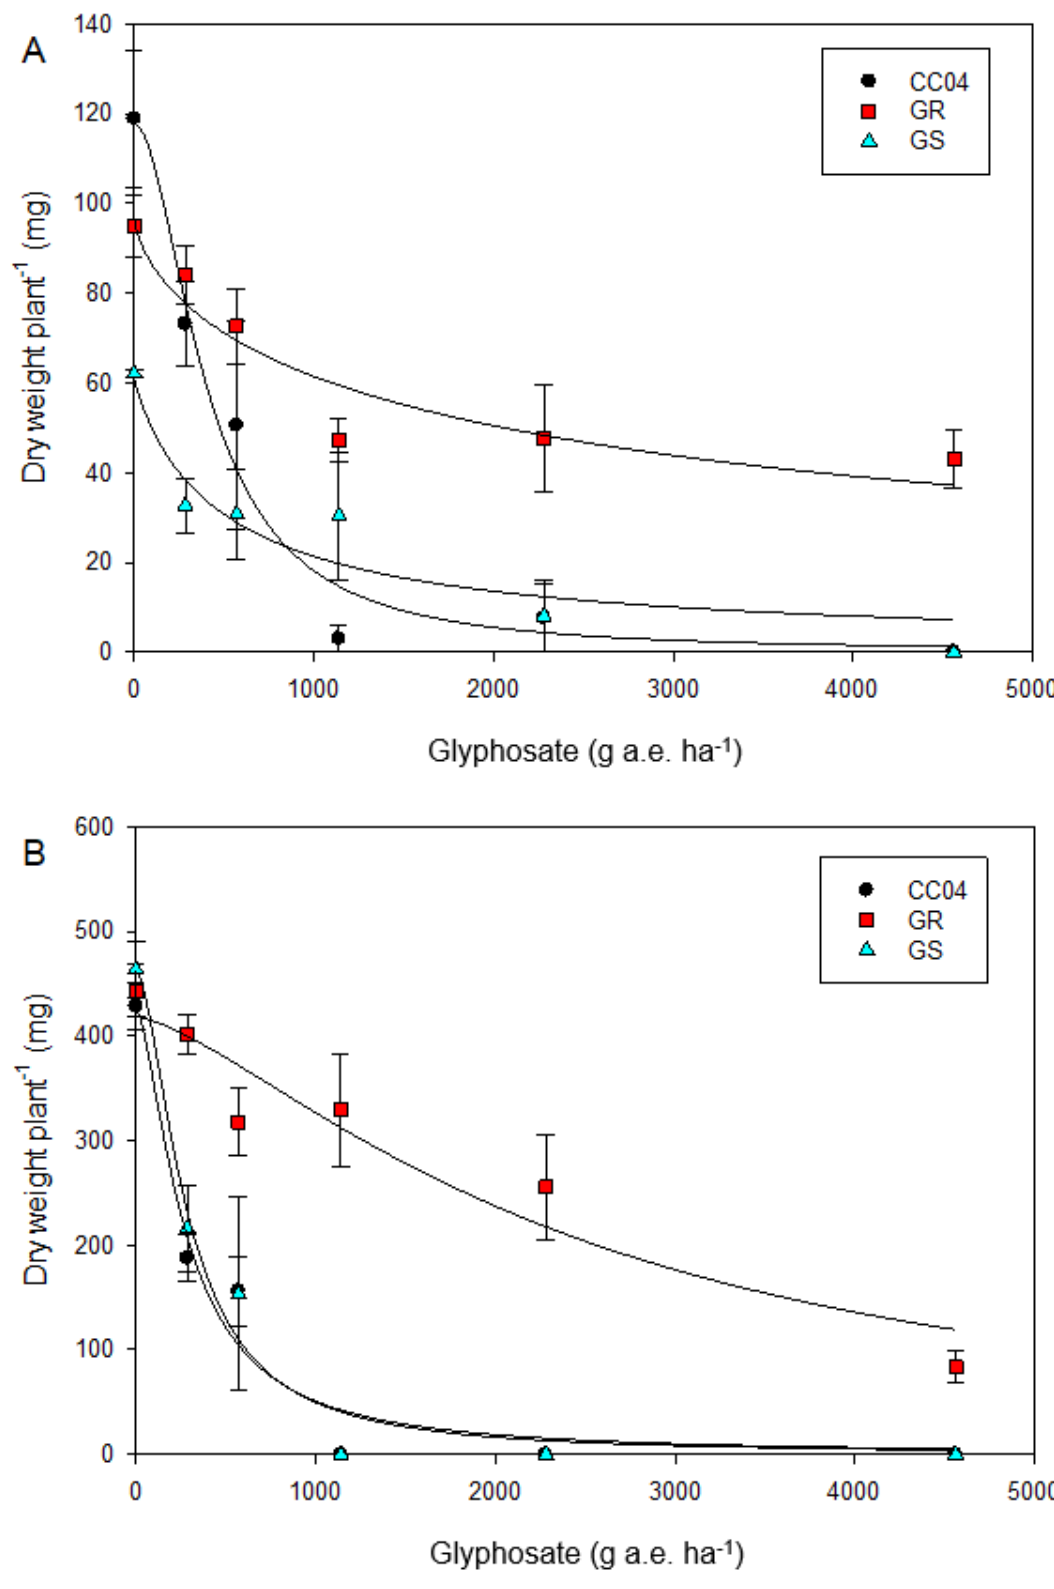
Figure 2. Dry weight per plant of three Lolium rigidum populations (CC04, GR, and GS) to six rates of glyphosate in ( A ) 2019 and ( B ) 2020. Data are presented as the average dry weight per plant and error bars represent the standard error of the mean.